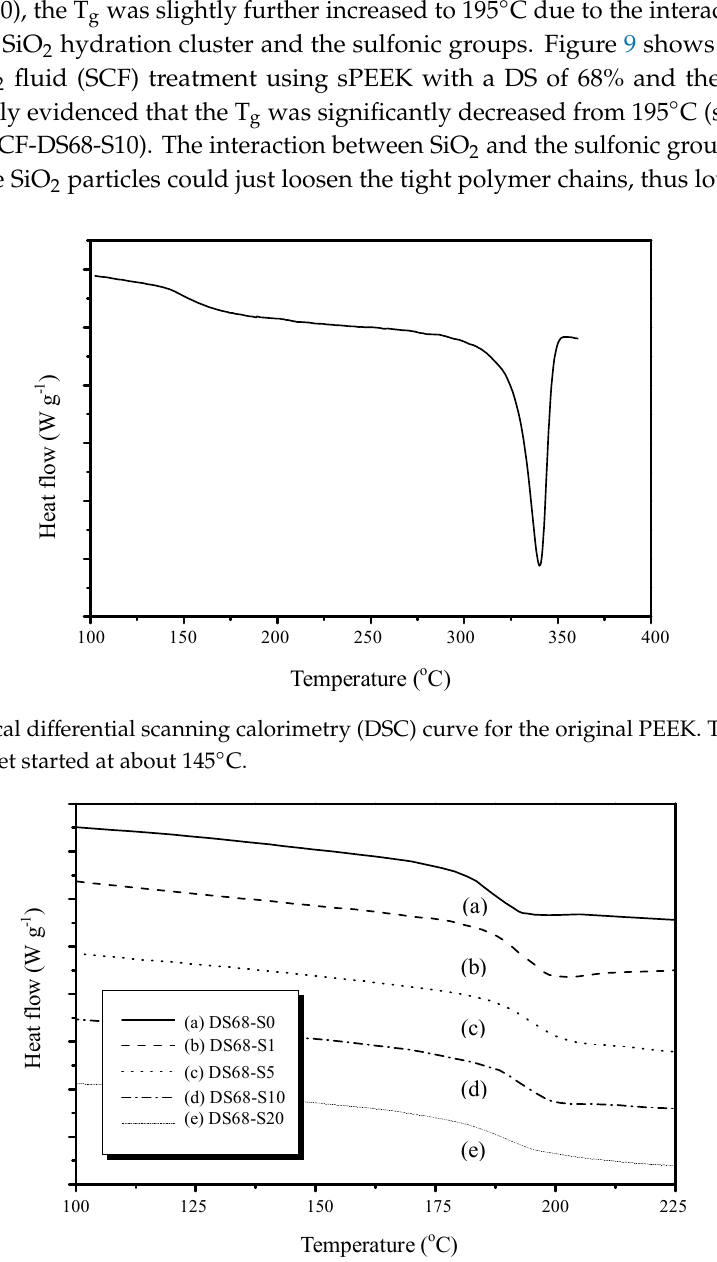
Figure 8. DSC curves for the sPEEK composite membranes with different SiO 2 contents. The sulfonated sPEEK exhibited much higher T g than the original PEEK polymer. The incorporation of nano particles increased T g even more.